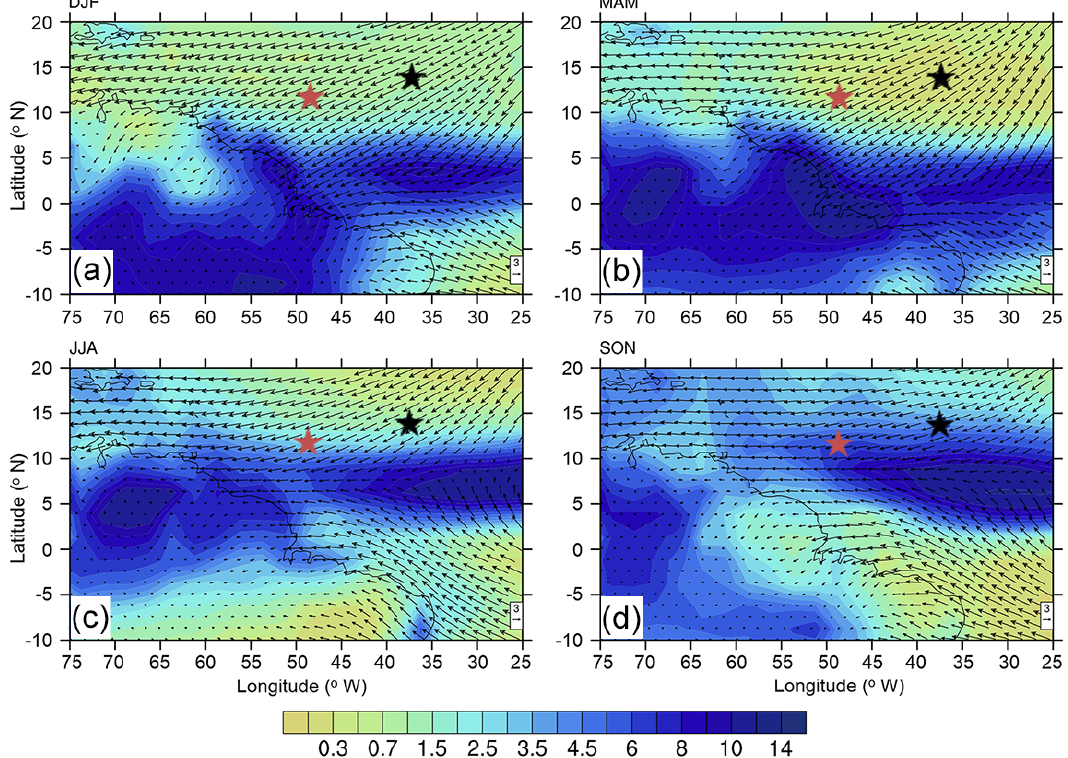
Figure 8. Climatological seasonal means of wind (speed and direction; reference vector length: 3ms − 1 ) and precipitation rates (colour shading; mm/day) over the central-western equatorial Atlantic Ocean for boreal (a) winter (December–February), (b) spring (March–May), (c) summer (June–August), and (d) autumn (September–November) illustrating the seasonal latitudinal migrations of the Intertropical Con- vergence Zone (ITCZ). Wind data (years: 1988–2015) were obtained from the CCMP Ocean Surface Wind Vector Analyses (Atlas et al., 2011) and precipitation data (years: 1979–2015) from the CPC Merged Analysis of Precipitation (CMAP; Xie and Arkin, 1997). Red and black stars refer to the location of sites M4 and M2,